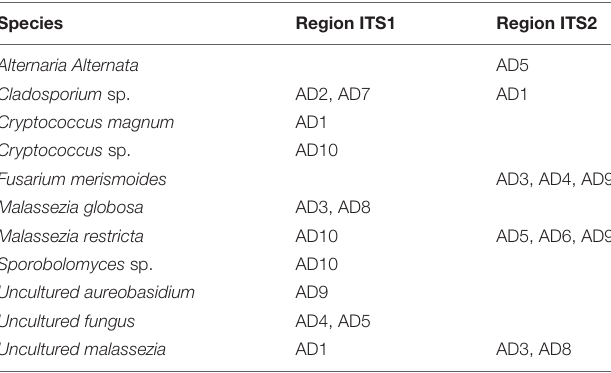
TABLE 1 | Fungal species detected in the frontal cortex (FC) of Alzheimer’s disease (AD) patients by PCR and DNA sequencing.